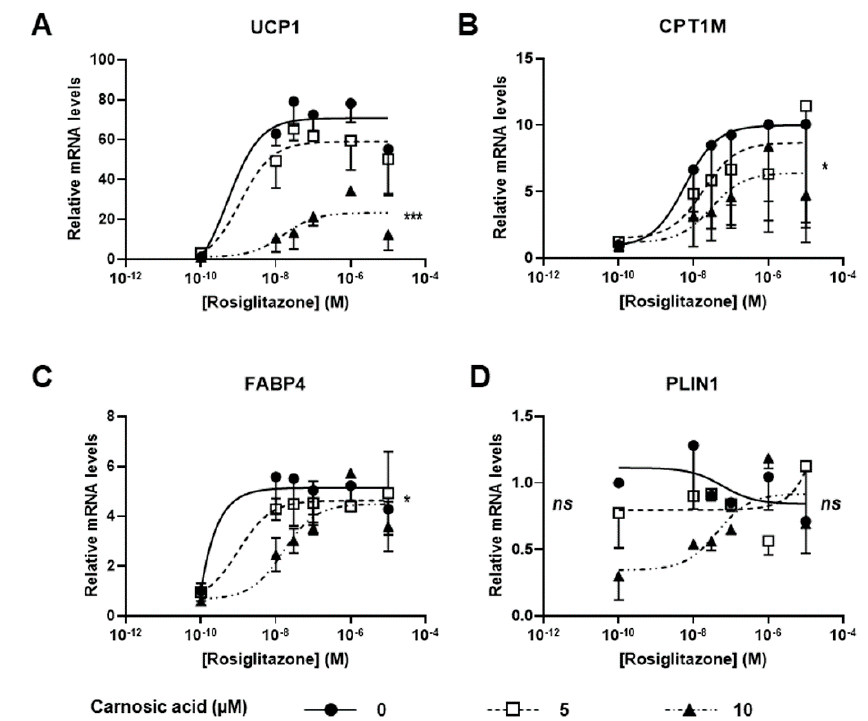
Figure 3. Efficiency of CA against rosiglitazone: conversion into brite adipocytes of white hMADS adipocytes was induced (between days 14 and 18) in the presence of varying amounts of rosiglitazone (10 nM–10 µM) in the absence ( ● ) or the presence of 5 ( □ ) or 10 ( ▲ ) µM CA. mRNA levels of thermogenic (UCP1 and CPT1M ( A , B )) and adipogenic (FABP4, PLIN1, ( C , D )) markers were analyzed. Each point on the curves represents mean ± SEM of two independent experiments (two replicates for each experiments); one-way ANOVA followed by Tukey post hoc test, the untreated vs. CA 10 µM-treated condition: *, adjusted p < 0.05; ***, adjusted p < 0.01.